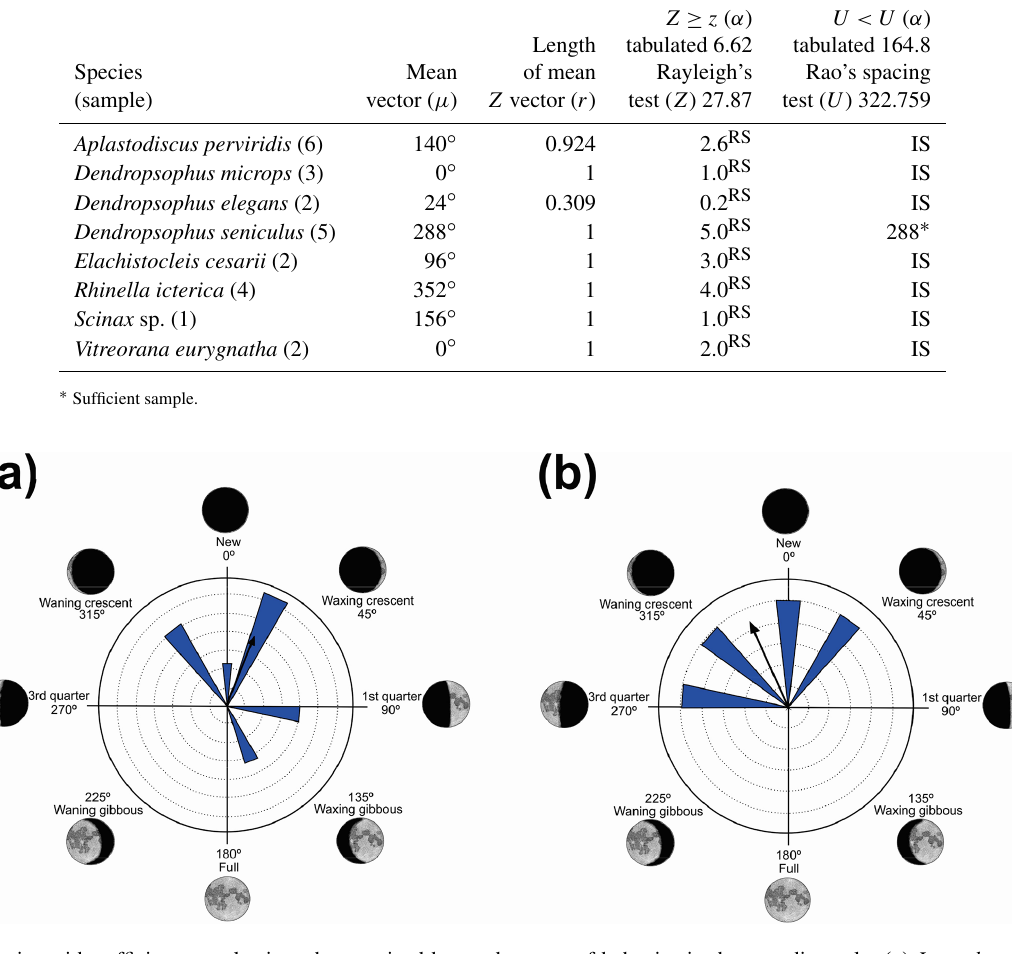
Figure 2. Species with sufficient sample size, characterized by randomness of behavior in the synodic cycle: (a) Leptodactylus jolyi and (b) Proceratophrys melanopogon